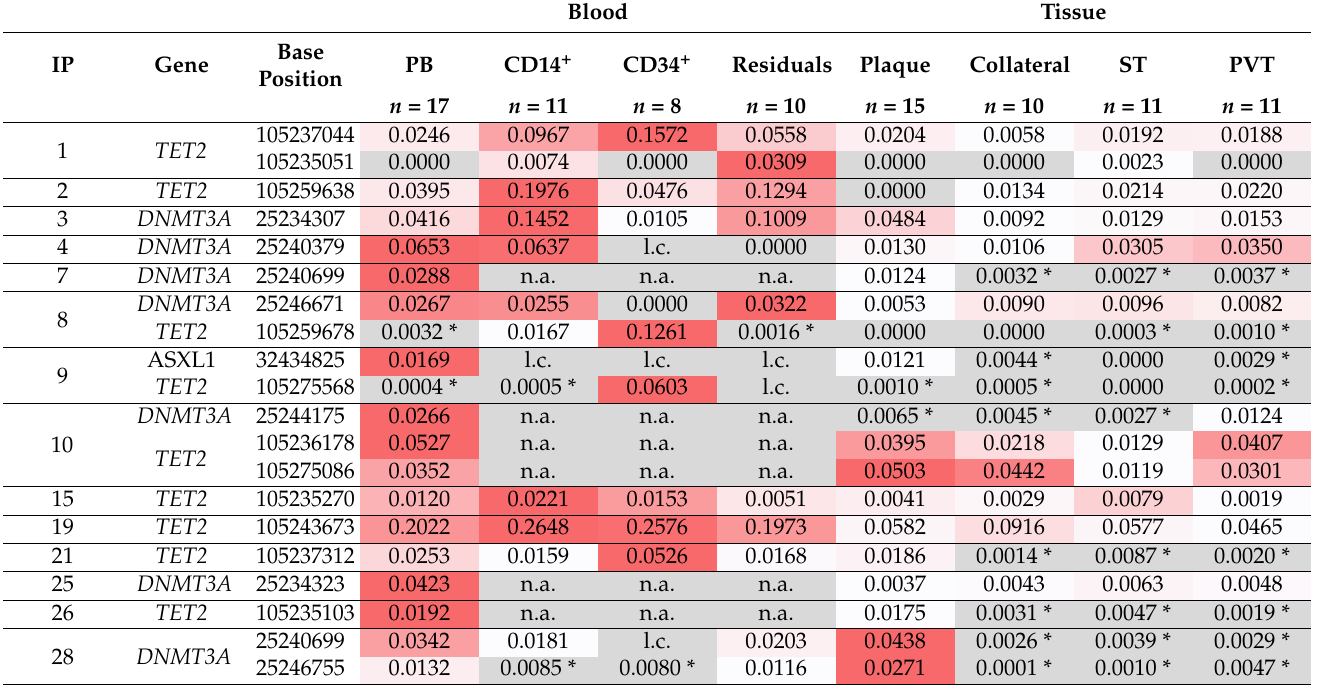
Table 2. CH driver mutations in patients with peripheral artery disease. First column—index patient (IP) in whom the variant was detected. Second/third column—affected gene and base position. Fourth–seventh column—variant allele frequencies (VAF) in blood. PB—peripheral blood; enriched blood sub-populations: CD14 + —monocytes, CD34 + —progenitor cells, residuals—PB depleted of monocytes and progenitor cells. Eighth–eleventh column—VAF in tissues, ST = subcutaneous tissue, PVT = perivascular tissue. Coloring indicates high (red), medium (pink) and low (white) VAF. Grey coloring indicates variant allele not found (0.00), VAF under detection threshold (marked with asterisk), l.c. = low coverage (fewer than 200 reads) due to low cell yield from enrichment, n.a. = not analyzed as sample was not